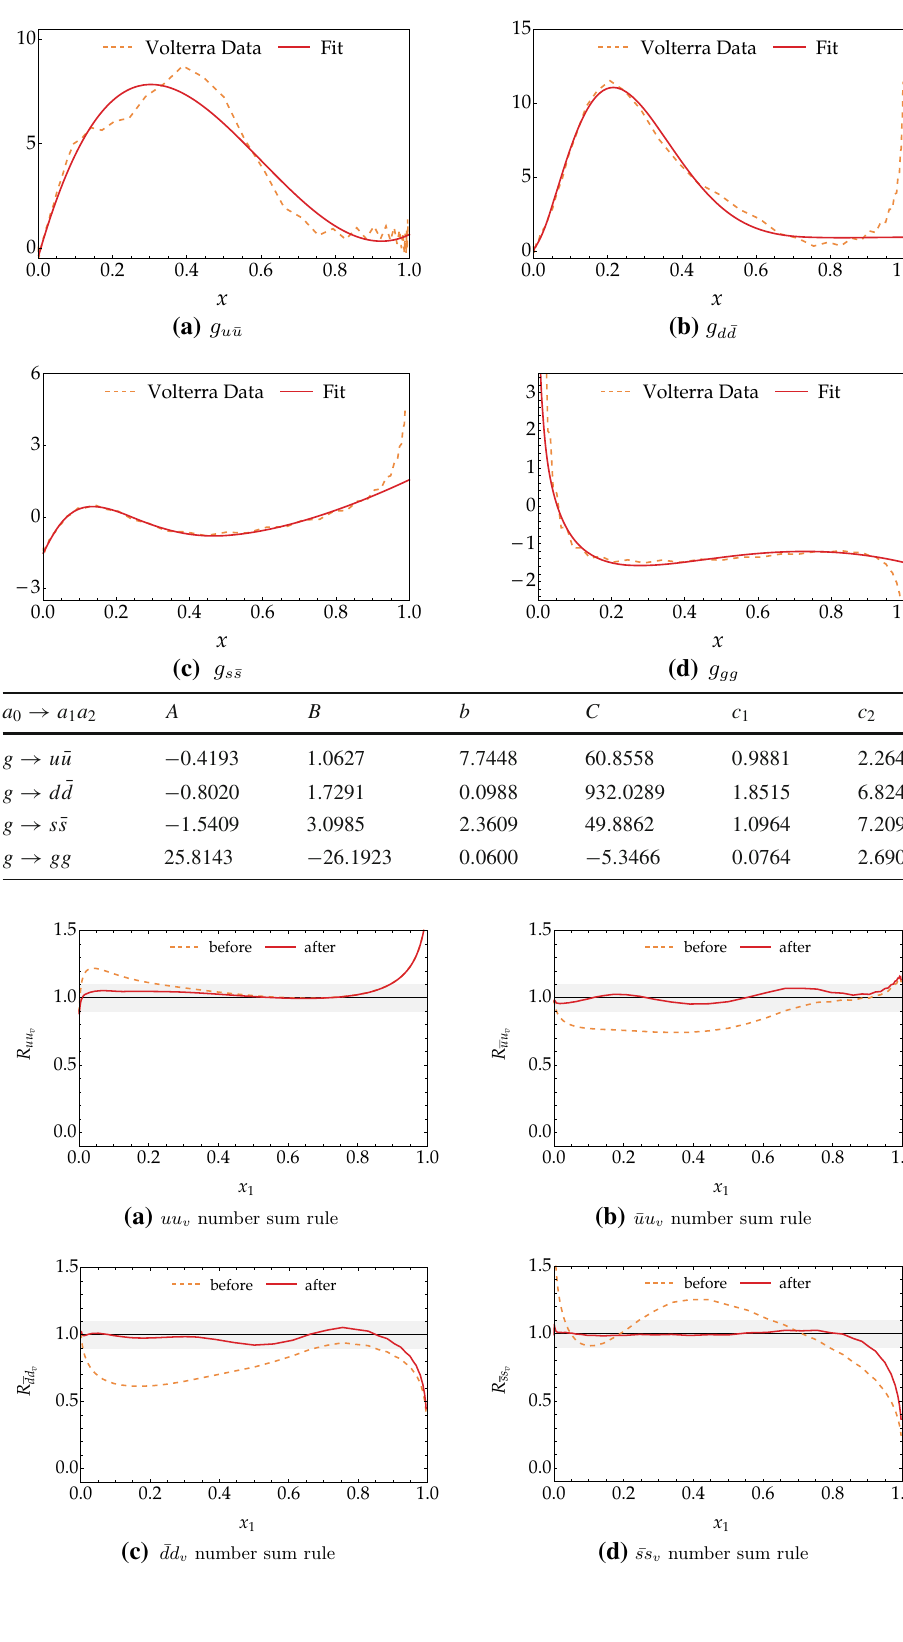
Fig. 8 Modification functions ( x ) for the g → q ¯ q and g a 1 a 2 g → gg splittings. For each channel we display the fit to the form (37) and the direct solution of the discretised Volterra equation (36). The direct solution is shown as a dashed curve with linear interpolation between each data point